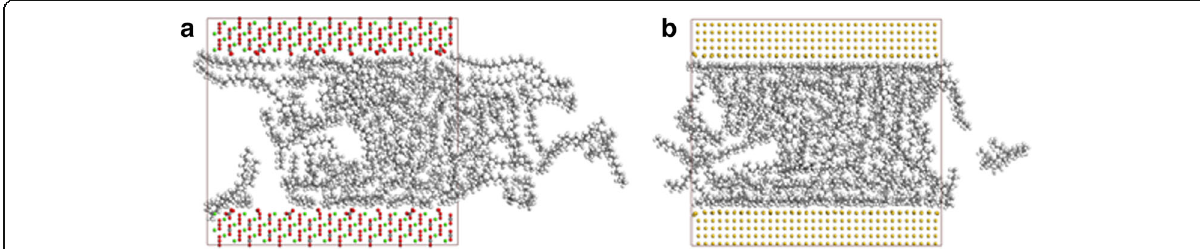
Fig. 9 Snapshots of octadecane transportation in 4 nm a calcite channel and b gold channel at 2 ns. Color code for atoms: green, calcium; yellow, gold